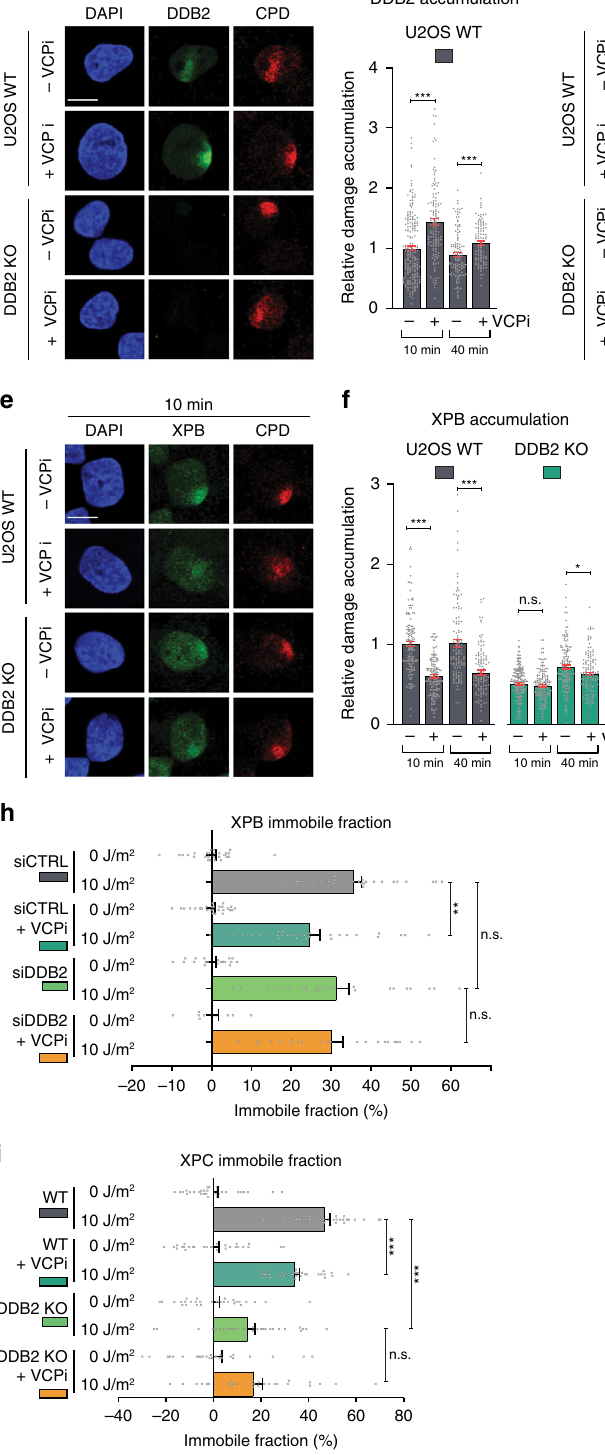
Fig. 3g), unequivocally showing that the reduced XPC and XPB accumulation after VCPi is dependent on DDB2. Previously, it was shown in in vitro cell-free NER excision and reconstituted NER assays that the CRL4 DDB2 complex blocks repair in the absence of functional ubiquitylation, because of which it was suggested that ubiquitylation regulates the displacement of DDB2 by XPC at DNA lesions 23 . Together with our data, this supports a